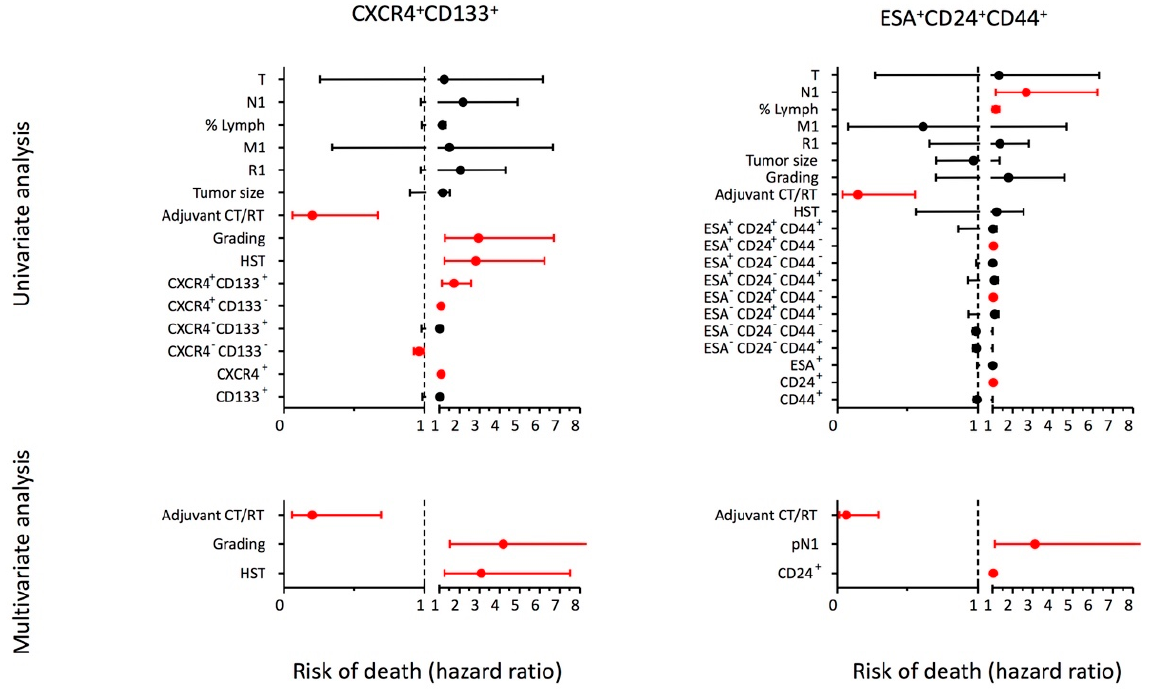
Figure 6. Univariate and multivariate hazard ratios for PDAC mortality. The associations be- tween baseline variables, tumor stemness according to CXCR4 + CD133 + (left panels, n = 46) or ESA + CD24 + CD44 + cell percentage (right panels, n = 41), and PDAC mortality were assessed by Cox regression analysis. All analyzed variables are presented. Dots represent the hazard ratio after lines of the 95% confidence intervals. Red dot/lines p < 0.05. CT/RT: chemo/radiotherapy; HST: high stemness tumor (see the